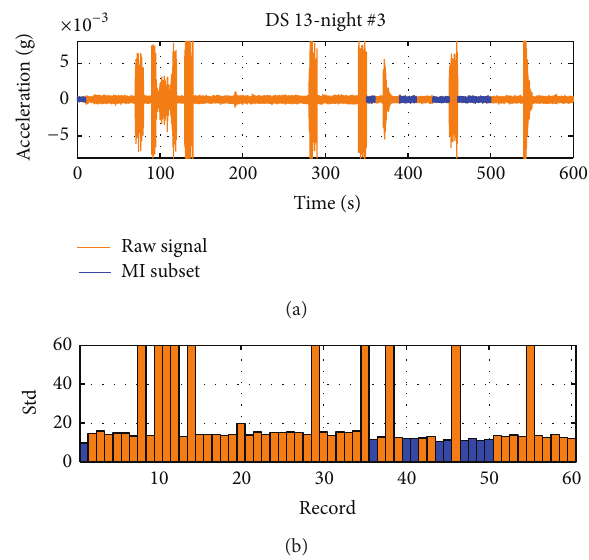
Figure 3: (a) Complete time history and (b) STD values for night #3 of dataset DS 13; the subset considered for the MI computation is highlighted in